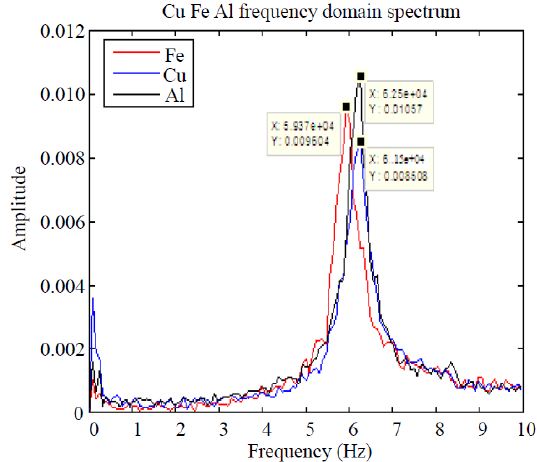
Fig. 4 Frequency change diagrams of pure Cu, Fe, and Al plasma shock wave acoustic emission signal with the change pulse energies and detection